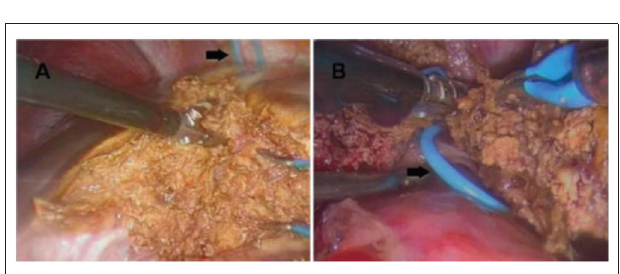
FIGURE 4 | (A) Parenchymal transection during a left hepatectomy, performed with a thermofusion device. (B) The hepatic vein previously controlled with a vessel loop (black arrow) is sectioned at the end of liver division. From Tranchart et al. ( 34).